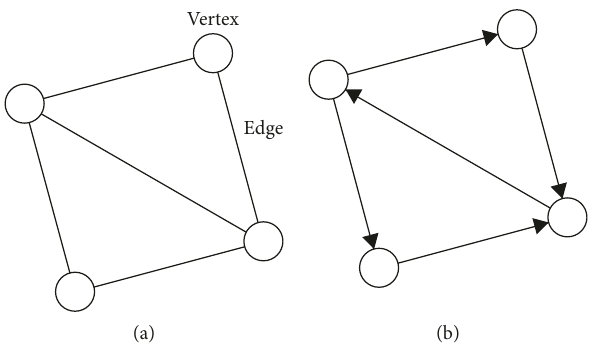
Figure 1: (a) Undirected graph. (b) Directed graph.